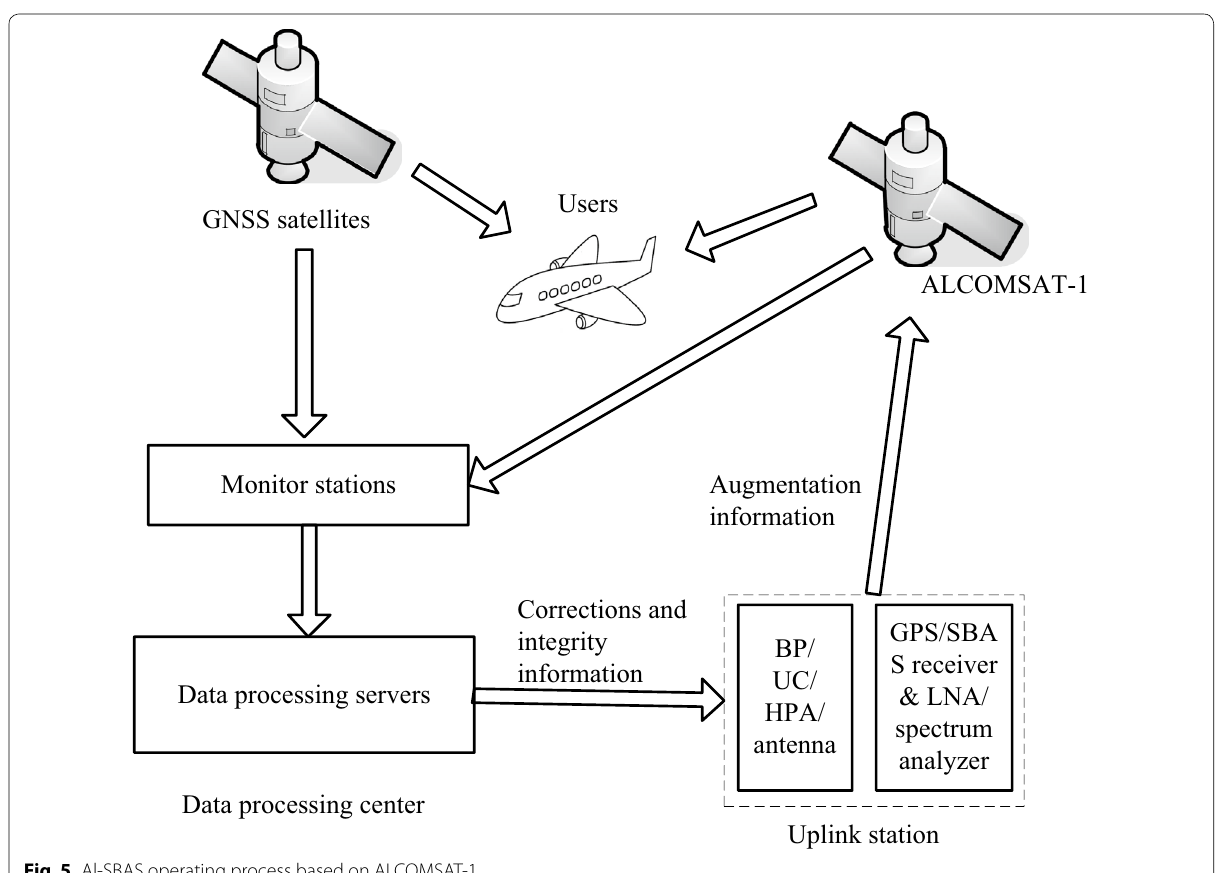
Fig. 5 Al-SBAS operating process based on